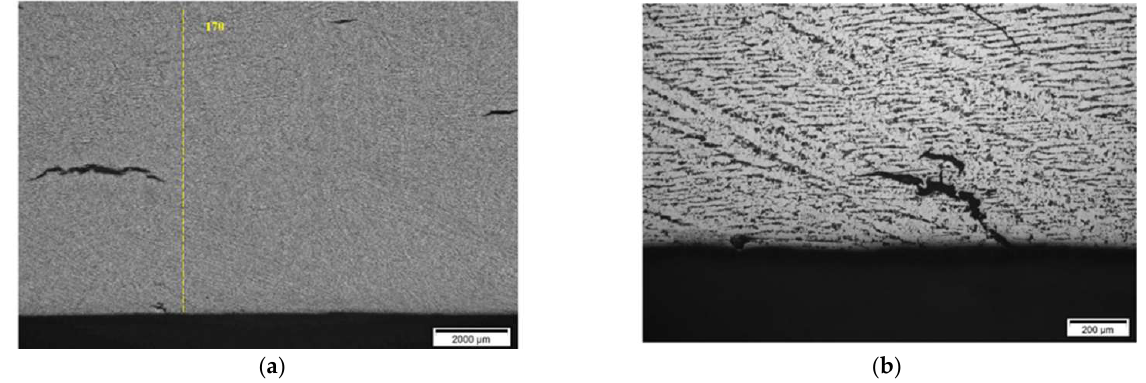
Figure 25. Section No3: 142–198. Coordinate 170 mm. Magnification 12.5× ( a ), Cracking near ID surface, magnification 100× ( b ).